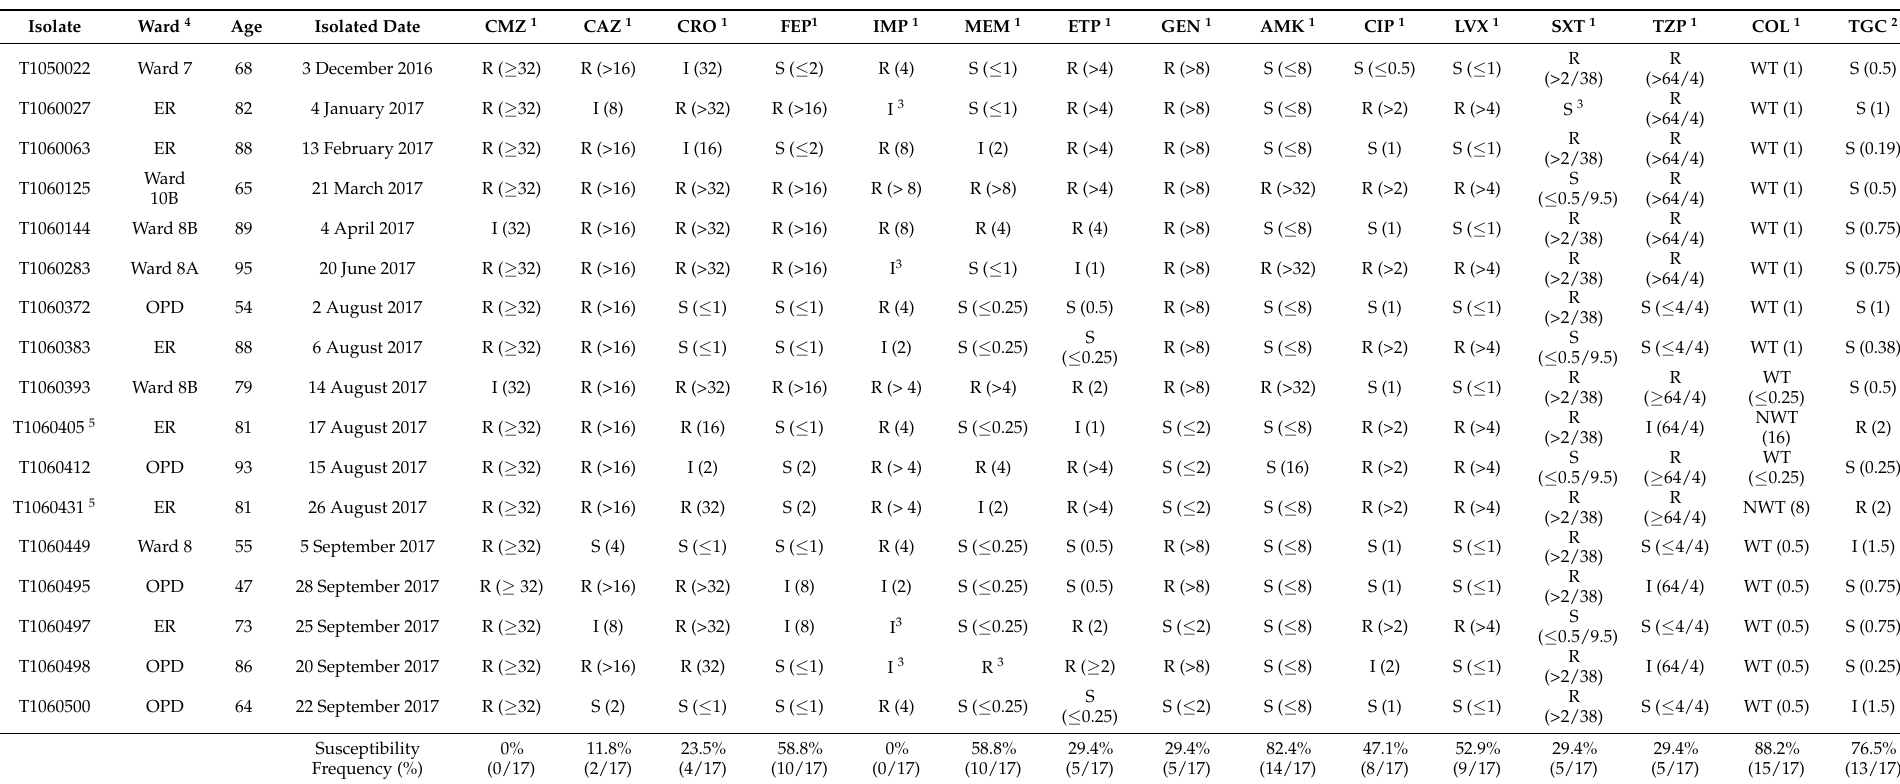
Table 1. Antimicrobial susceptibility tests of 17 carbapenem-resistant K. pneumoniae isolates from urine at Taipei Medical University